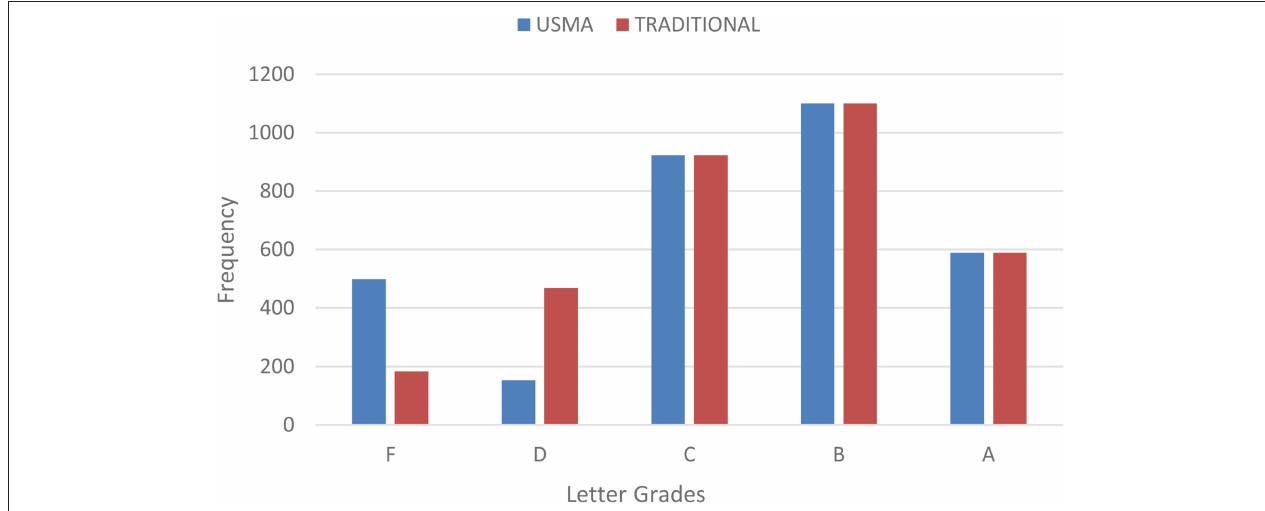
FIGURE 1 | Distribution of letter grades for WPR1 by type of grading